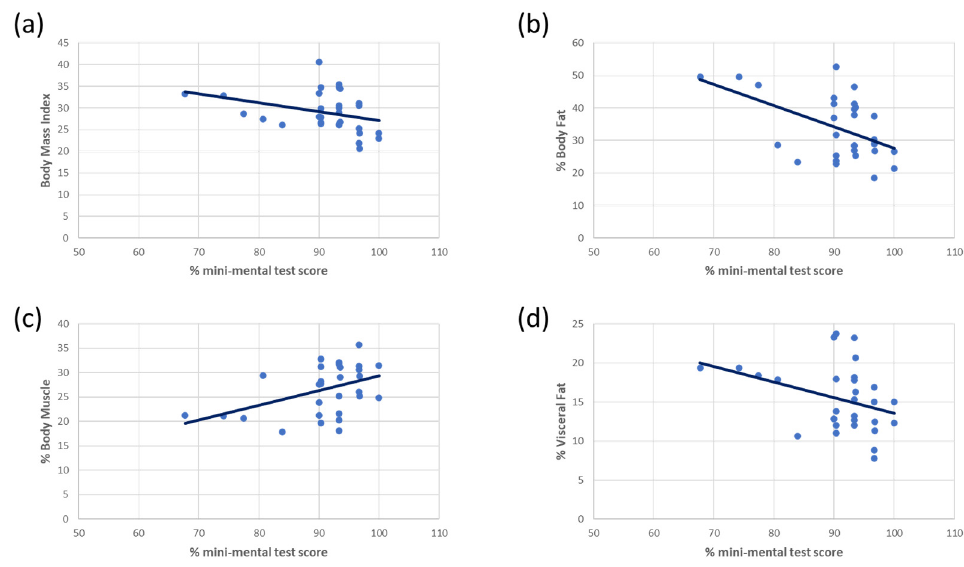
Figure 3. Metabolic parameters are good predictors of scores obtained in the MMSE.